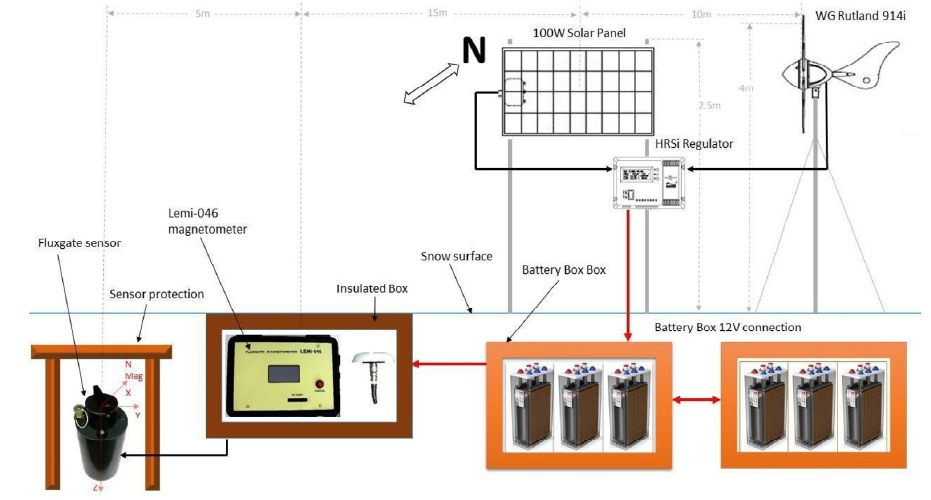
Figure 3. Overall configuration of the station on the field.